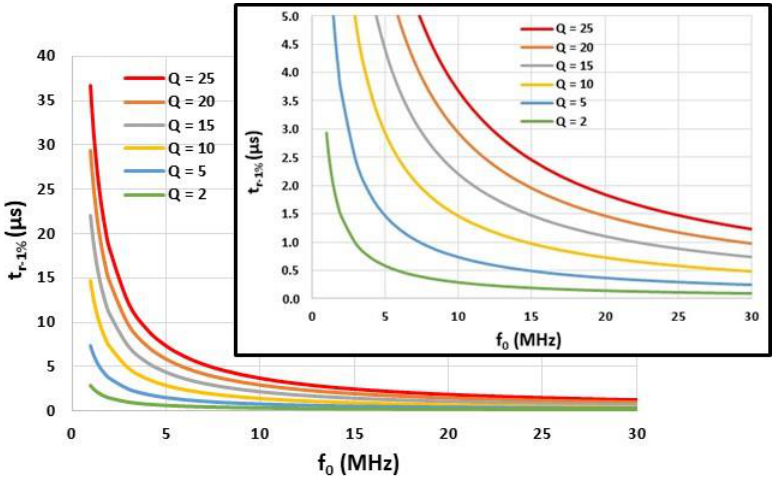
Figure 5. Response time 𝑡 𝑟−1% computed from Equation (3) as a function of the resonant frequency 𝑓 0 and for different quality factors 𝑄 .